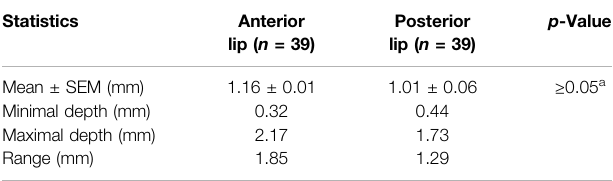
TABLE 2 | Depth of anterior and posterior cervical lip tissue